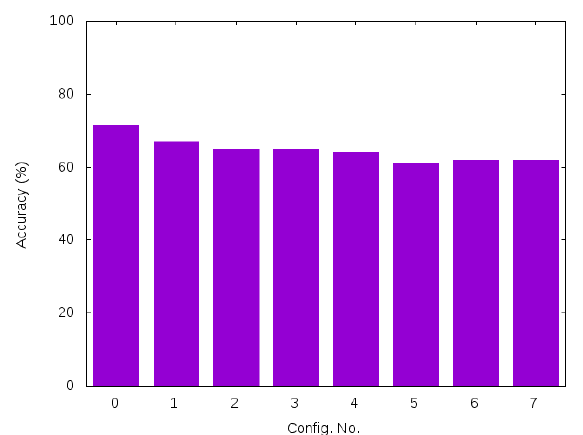
Figure 5. Accuracy for different